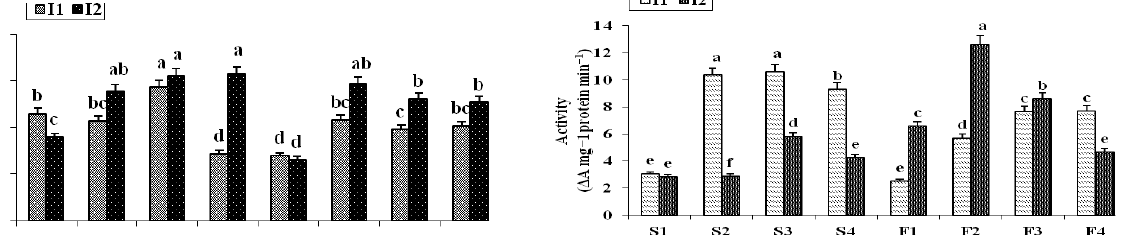
was proportional with the Fe levels; namely, the highest SOD